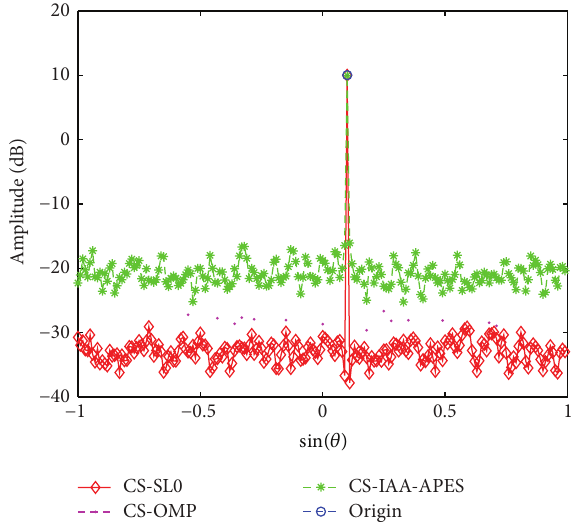
Figure 2: The DOAs of three different methods with one incident signal (SNR =